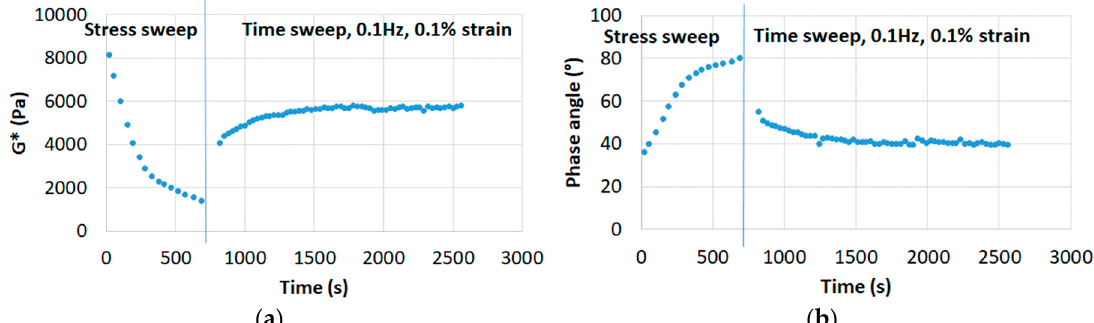
Figure 10. The recovery after stress sweeps on a 2% fiber sample (50 °C, 0.1 Hz): ( a ) complex modulus and ( b ) phase angle.